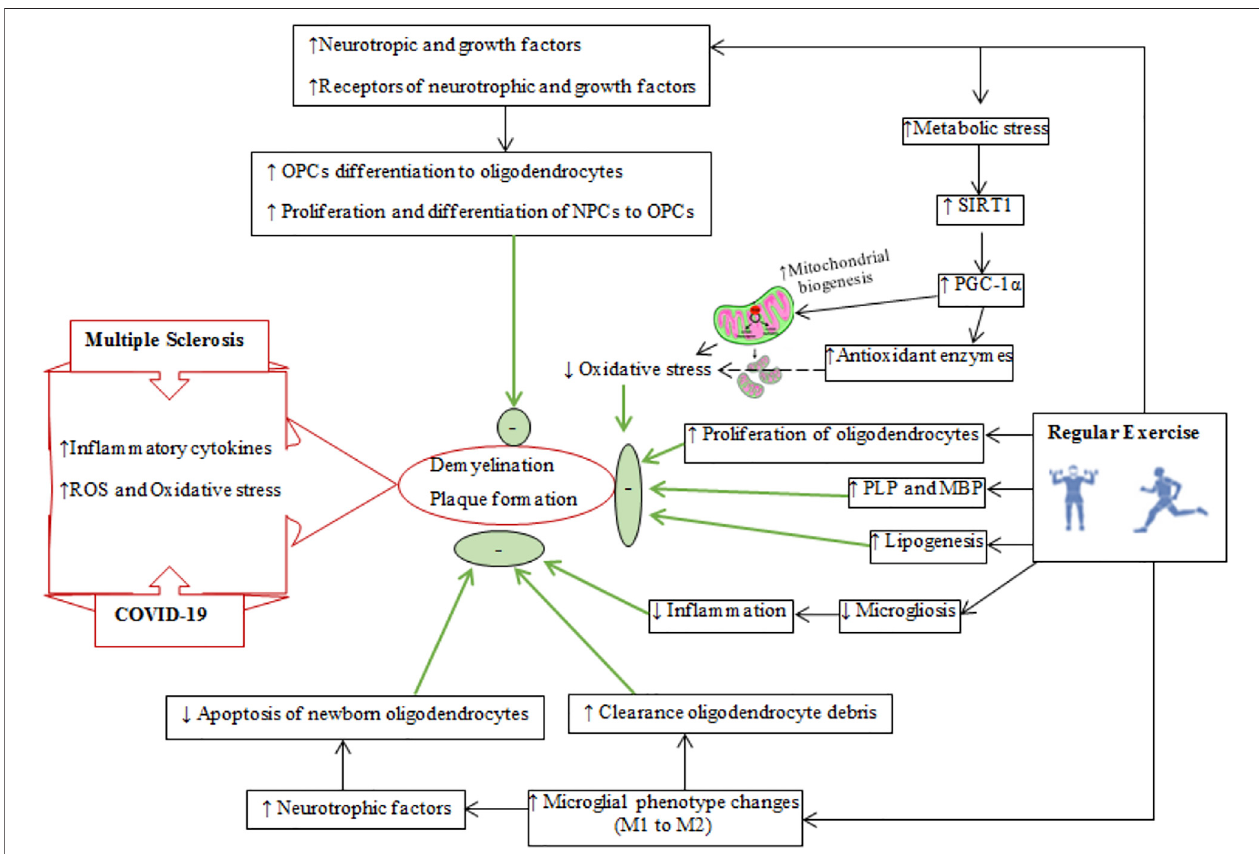
FIGURE 6 | Schematic diagram of demyelination and plaque formation in multiple sclerosis and COVID-19. The reparative effects of regular exercise on reducing demyelination and improving remyelination are shown on right side. The fi nal effects of regular exercise are shown by thick green arrows and green circles and oval shapes. SIRT1,silentmatingtypeinformationtraining;PGC-1 α ,peroxisome proliferator-activatedreceptor-gammacoactivator-1alpha;PLP,myelinproteolipid protein; MBP, myelin basic protein; NPCs, neuronal precursor cells; OPCs, oligodendrocyte precursor